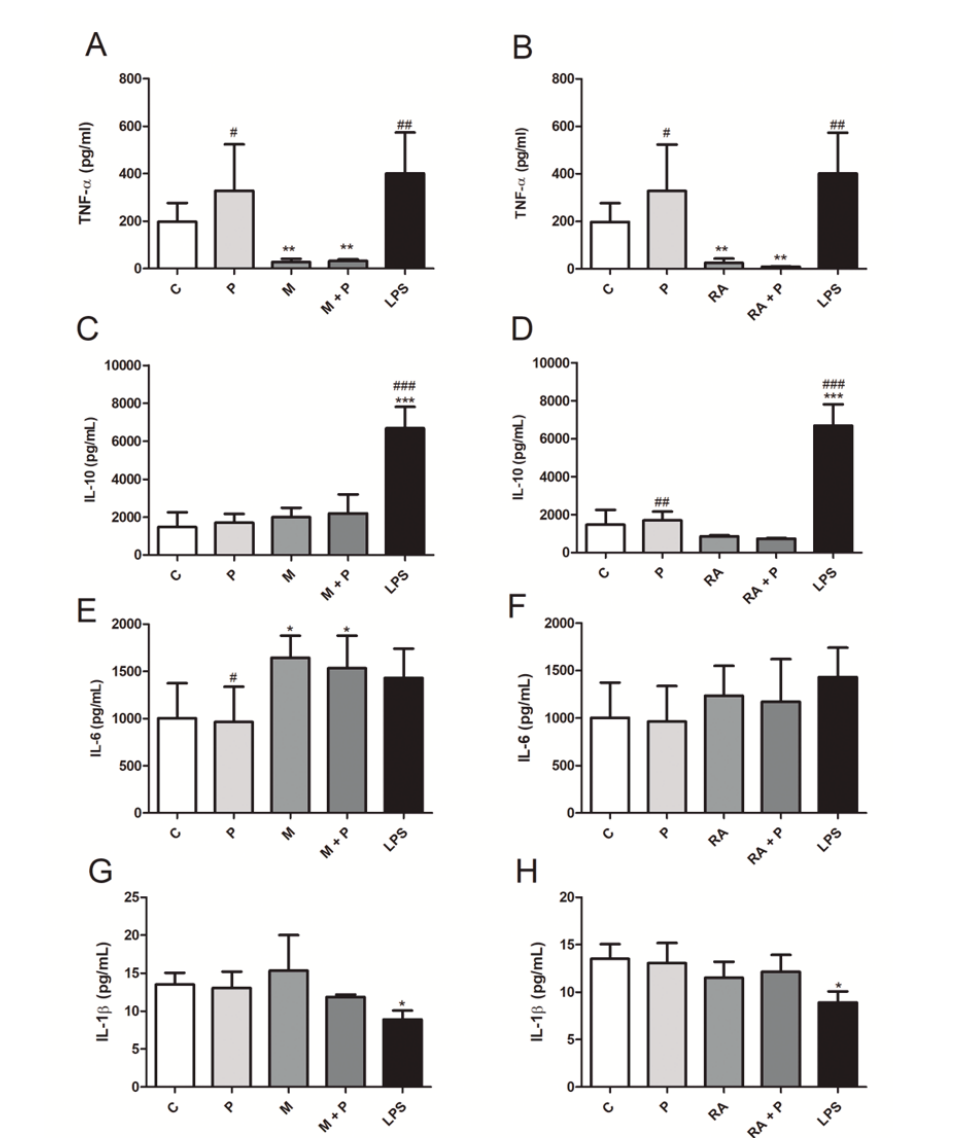
Figure 3. Cytokine production (pg/mL) by dendritic cells (1 × 10 6 cells/mL) after 48 h incubation with RPMI 1640 (control – C), propolis (P – 5 μg/mL), (A, C, E, G) MAGE-1 (M – 10 μg/mL), (B, D, F, H) retinoic acid (RA – 10 -7 M), their combination, and LPS (1 µg/mL). Data represent mean and standard deviation of five subjects. Significantly different from control: *( p < 0.05); **( p < 0.01); ***( p < 0.001). Significantly different from the respective combination: # ( p < 0.05); ## ( p < 0.01); ### ( p < 0.001).